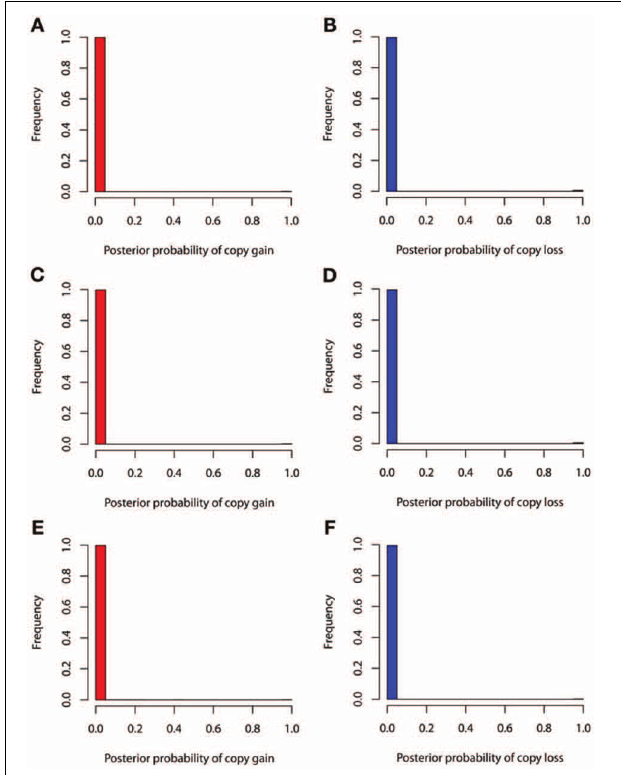
FIGURE 4 | True positive rates of detecting copy gain and copy loss under various standard deviations. (A) For copy gain when SD = 0 . 15, (B) for copy loss when SD = 0 . 15, (C) for copy gain when SD = 0 . 20, (D) for copy loss when SD = 0 . 20, (E) for copy gain when SD = 0 . 25, and (F) for copy loss when SD = 0 . 25.